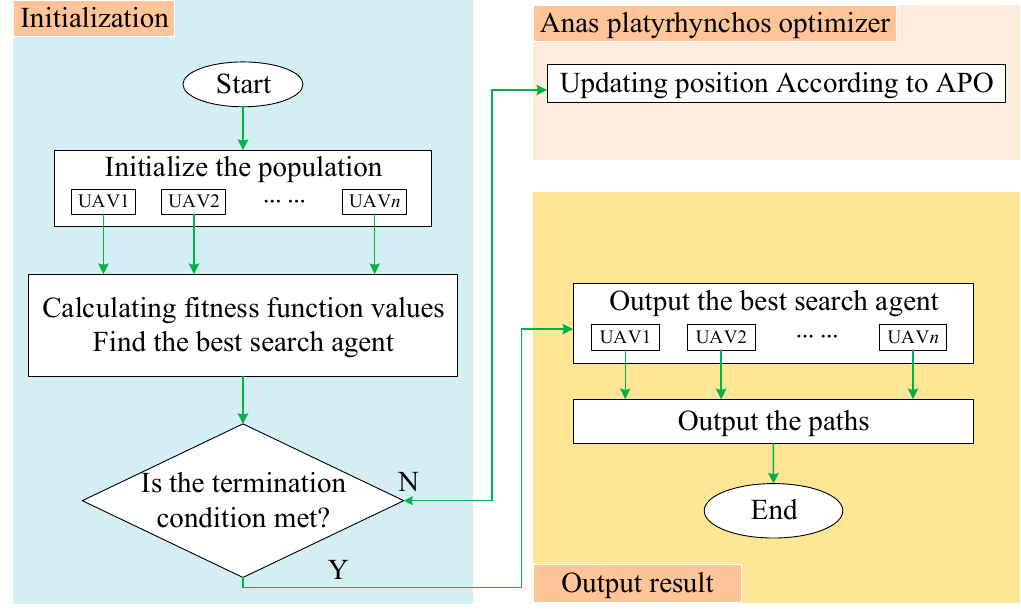
Figure 7. The specific flow of the multi-UAVs cooperative path planning based on APO.